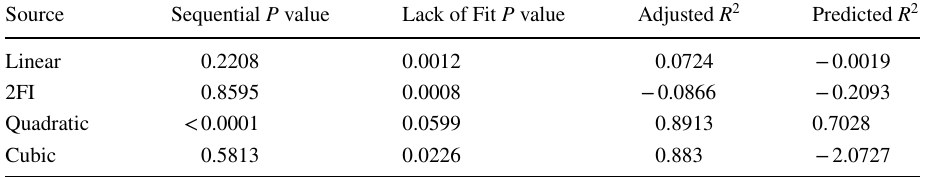
Table 4 Statistical adequacy evaluation of